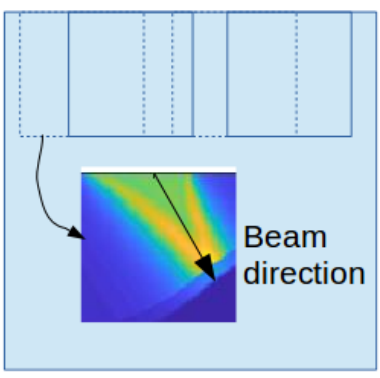
Figure 5. Calculating the direction of Gaussian beam with the superficial layer TRI